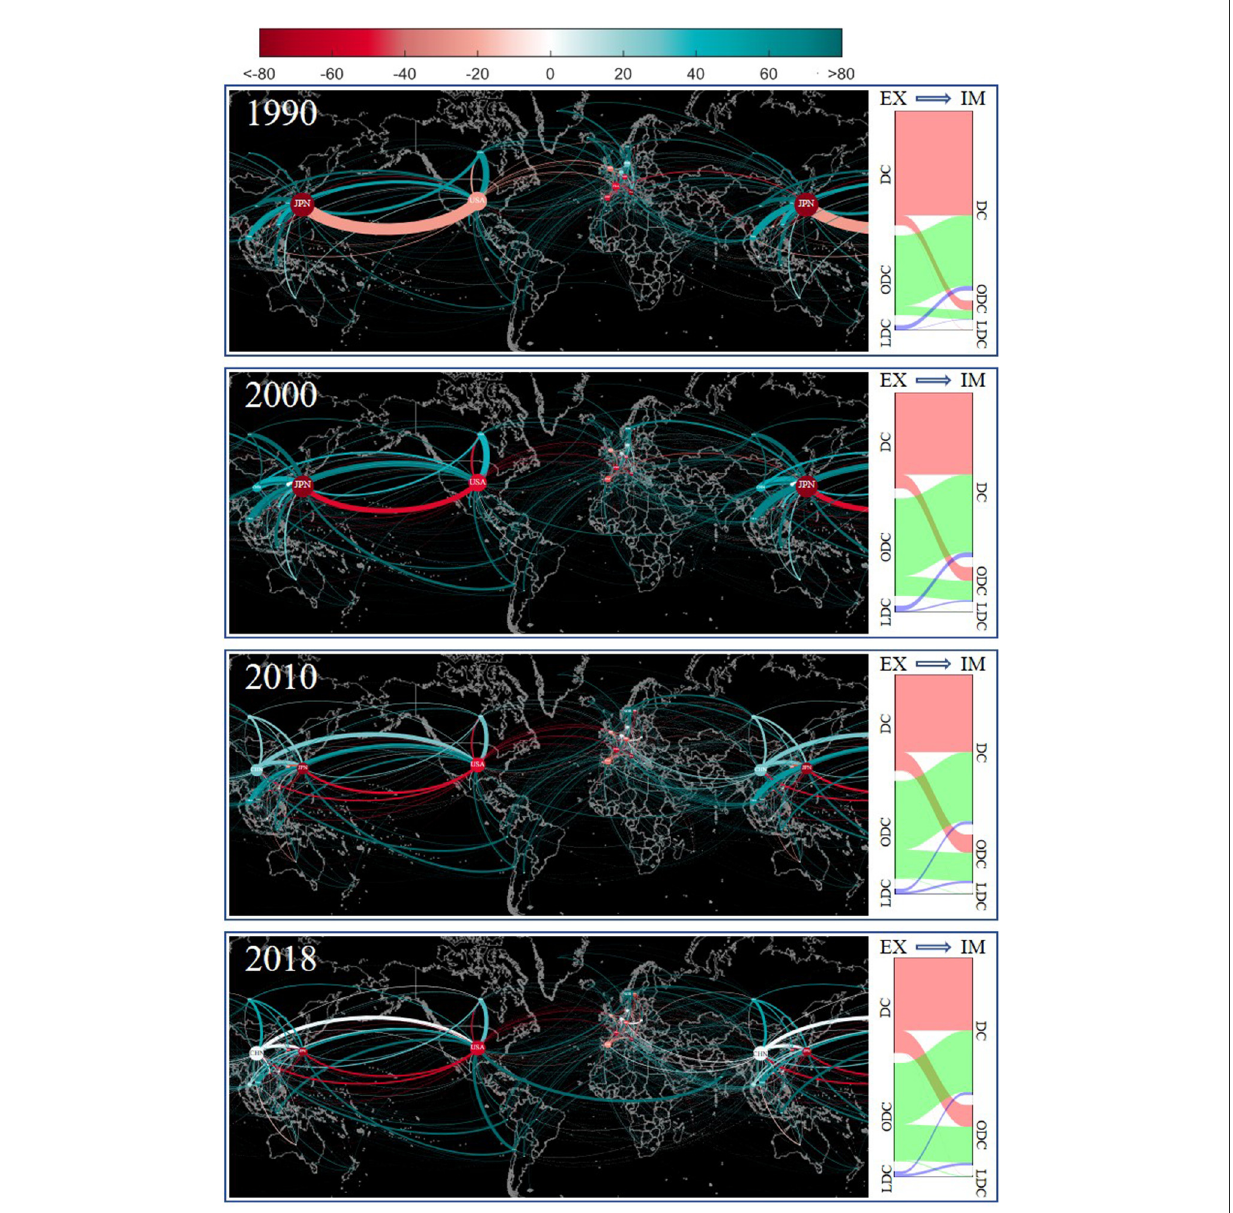
FIGURE2 Maps of ITN-Fish for 1990, 2000, 2010, and 2018. (Left) All nodes are displayed on the maps, while only edges with weights greater than 0.0001 are displayed. The size of the nodes is proportional to the tot-strengths; the thickness of the edges is proportional to their weights. The nodes are colored according to the percentage of the net-strength to the tot-strength. The color of the edges is consistent with the color of the exporters. See Supplementary Table S1, for the country associated with each acronym. (Right) Trade flows among developed countries (DC), other developing countries (ODC), and least developed countries